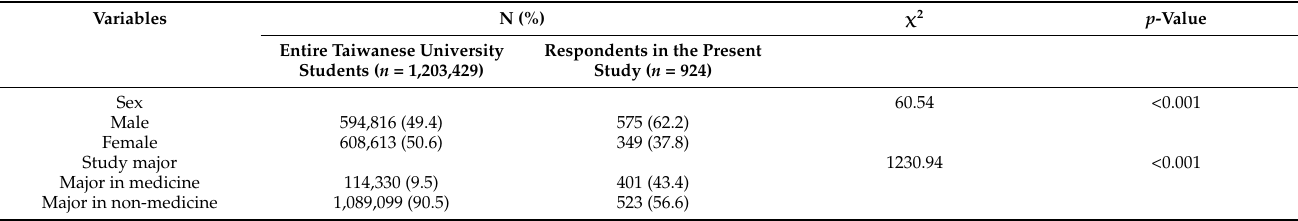
Table 1. Comparing sex and study major between the present study’s sample and the entire Taiwanese university student